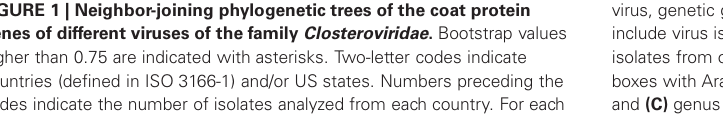
virus, genetic groups are indicated in gray boxes with Roman numerals and include virus isolates having nucleotide distances higher than 0.1 with all isolates from other clades. Subgroups or clades in CTV are indicated in darker boxes with Arabic numbers. (A) Genus Ampelovirus , (B) Genus Crinivirus , and (C) genus Closterovirus